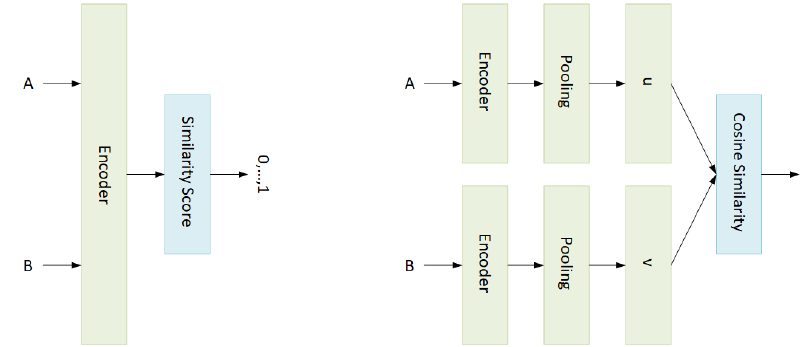
Figure 3. Cross-Encoder ( left ) versus Bi-Encoder ( right )